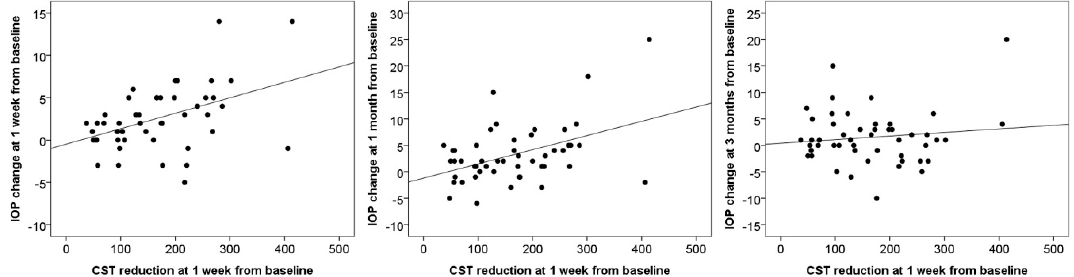
Figure 4. Scattergrams of intraocular pressure (IOP) changes versus central subfield thickness (CST) reductions. The amount of CST reduction at 1 week was significantly correlated with the degree of IOP change at 1 week and 1 month after intravitreal DEX implantation ( r = 0.443, p = 0.001; r = 0.445, p = 0.001, respectively). There was no significant correlation between the amount of CST reduction at 1 week and the degree of IOP change at 3 months ( r = 0.122, p = 0.404).